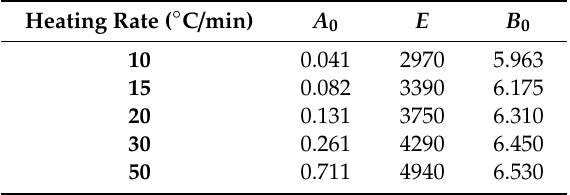
Table 3. Reaction parameters of polymerization kinetics at di ff erent heating rates using exponential curves of Figure